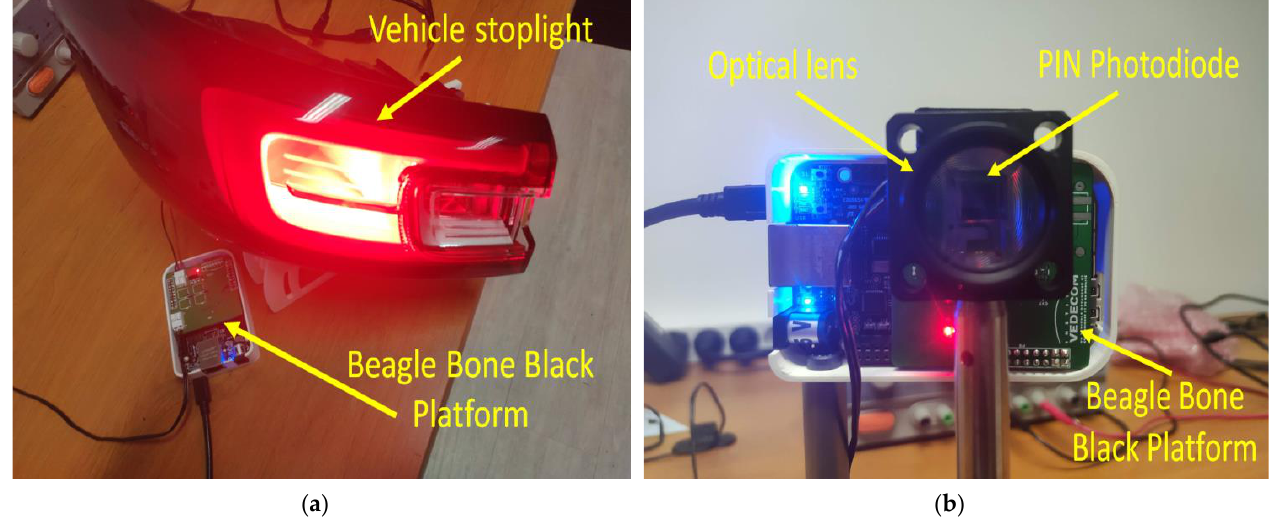
Figure 10. Hardware implementation of the vehicular visible light communications prototype: ( a ) vehicle stoplight VLC transmitter; ( b ) VLC receiver.